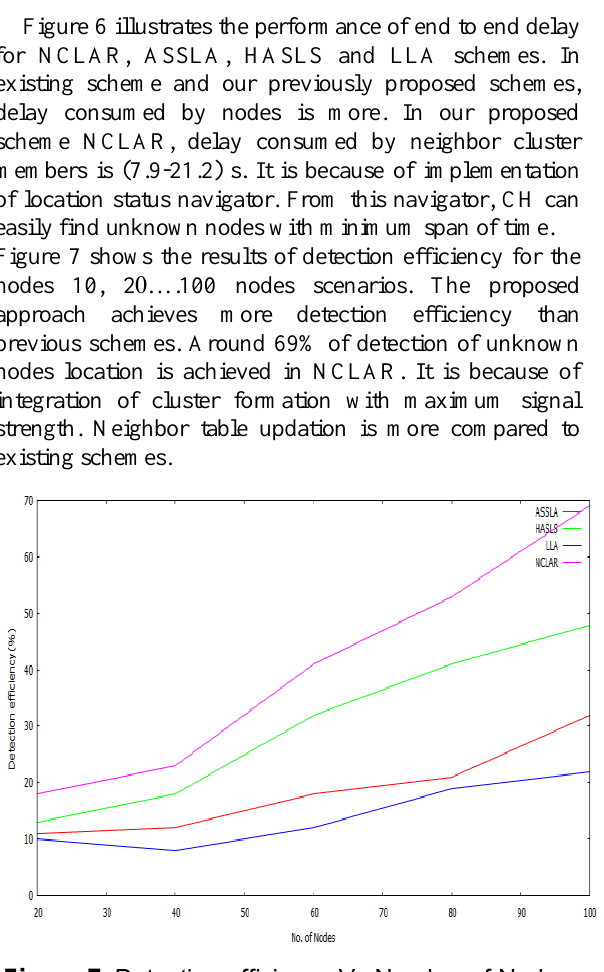
Figure 7. Detection efficiency Vs Number of